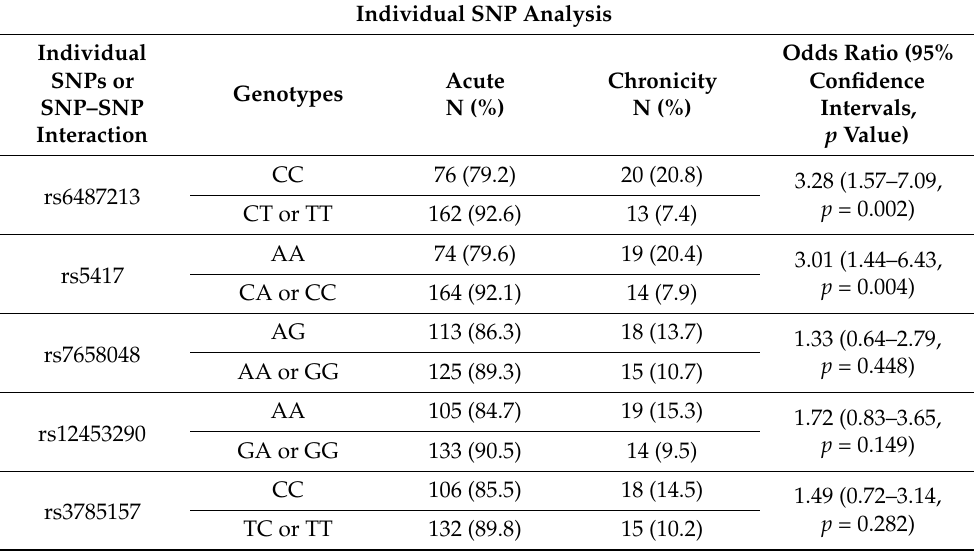
Figure 2. A decision tree model was developed to predict chronicity of drug-induced liver injury for 271 patients. Specifically, in the first layer, the genotype TT and TC of SNP rs6487213 will be assigned as acute, while the genotype CC will be continued to the next layer. In the second layer, the patient with the genotype AA of rs5417 will be assigned as chronic, otherwise, it will need further consideration. In the third layer, if the genotype GG of SNP rs12453290 was determined, the patient will be assigned as chronic and otherwise as acute. Table 2. Individual SNPs and SNP–SNP interaction analysis for their association with chronic drug-induced liver